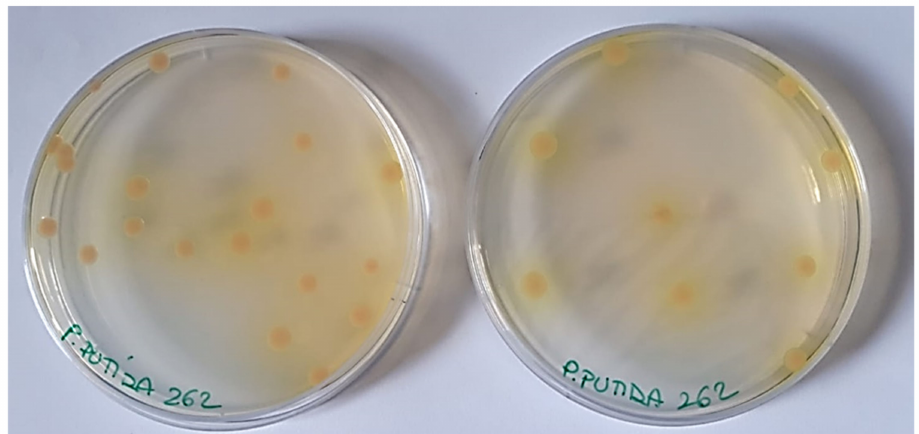
Figure 4. Colors of colonies of P. putida 262 clinical isolate producing